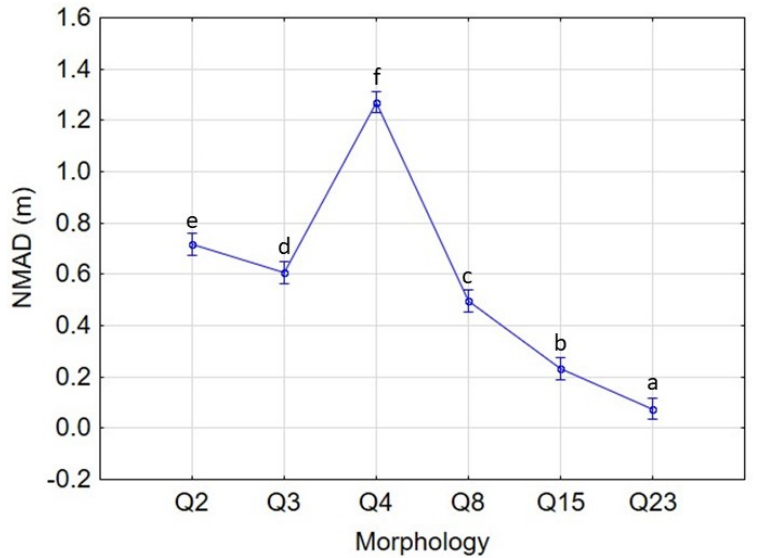
Figure 13. Plot of NMAD vs. Morphology factor. Vertical bars denote 95% confidence intervals. Different letters between morphologies indicate significant differences according to Tukey’s test ( p < 0.05).